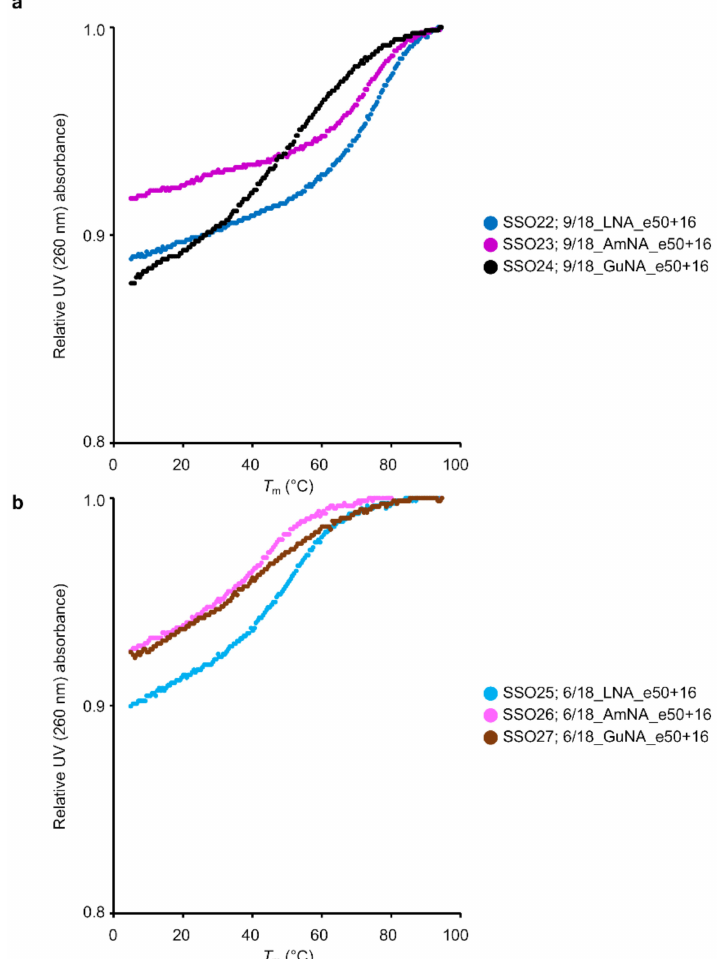
Figure 6. UV melting analysis of 18-mer LNA/AmNA/GuNA-modified SSOs targeting DMD exon 50 and having different modification content. ( a ) Results of UV melting experiments for single- stranded LNA-, AmNA-, and GuNA-modified SSOs having high modification content. ( b ) Results of UV melting experiments for single-stranded LNA-, AmNA-, and GuNA-modified SSOs having low modification content. All analyses were repeated three times to ensure reproducibility (see Supplementary Figure S5). The relative UV absorbance depicts normalized data (normalized by UV absorption at 94.5 ◦ C set to